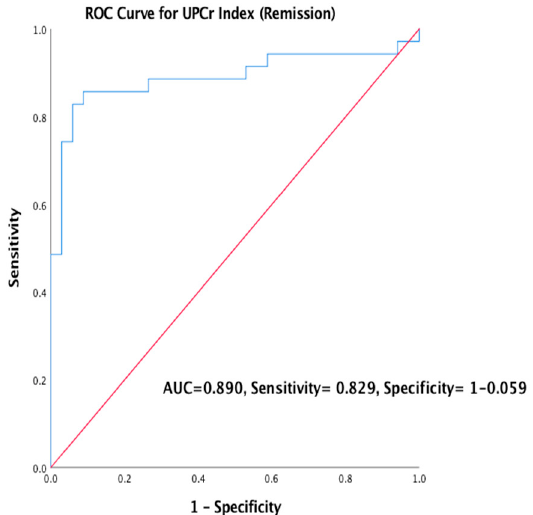
Figure 3. ROC Curve was used to validate the predictors of outcome using UPCr Index (Remission).